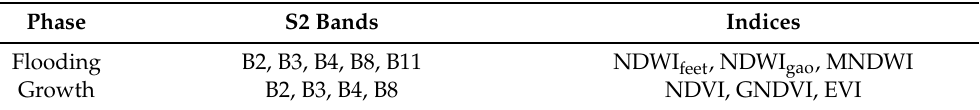
Table 4. Characteristics of the learning matrix by